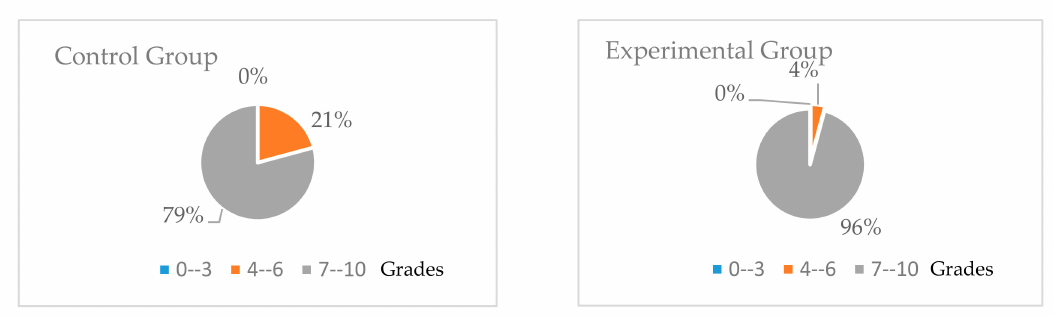
Figure 4. Test result: sound propagation.